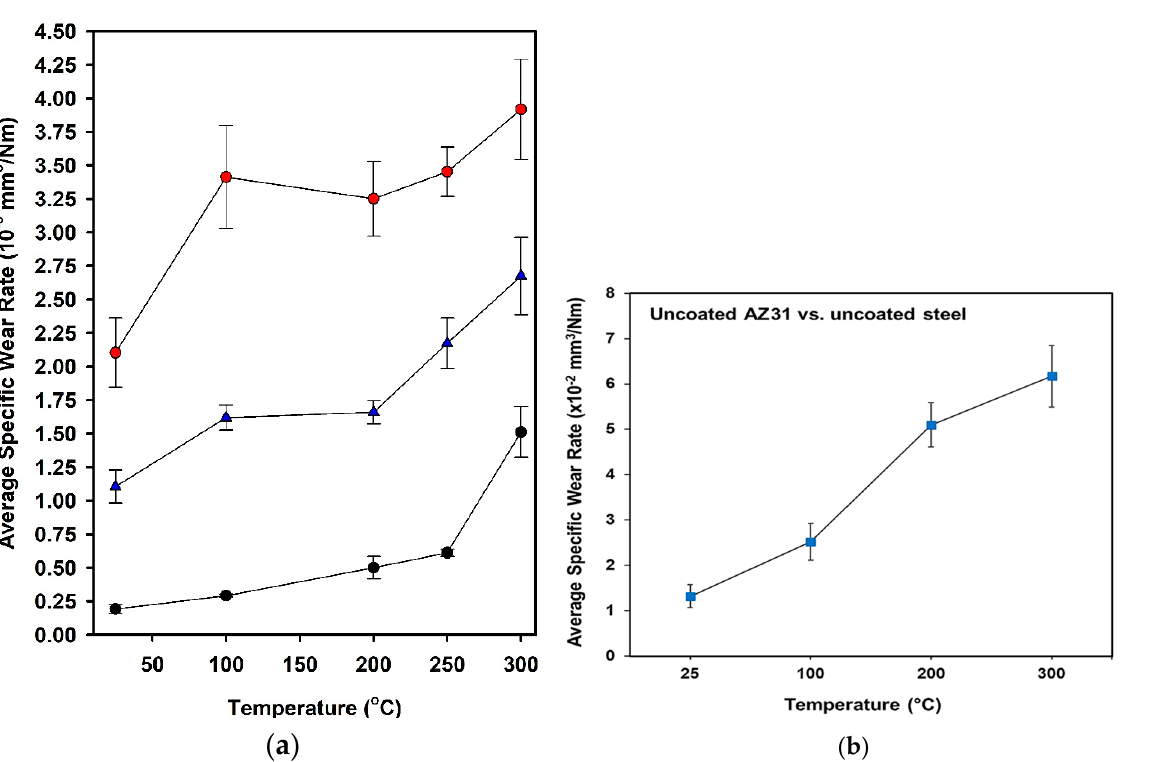
Figure 5. ( a ) The specific wear rates for PEO-coated AZ31 vs. uncoated steel, uncoated AZ31 vs. a- C-H and PEO-coated AZ31 vs. a-C-H systems; ( b ) uncoated AZ31 tested against uncoated